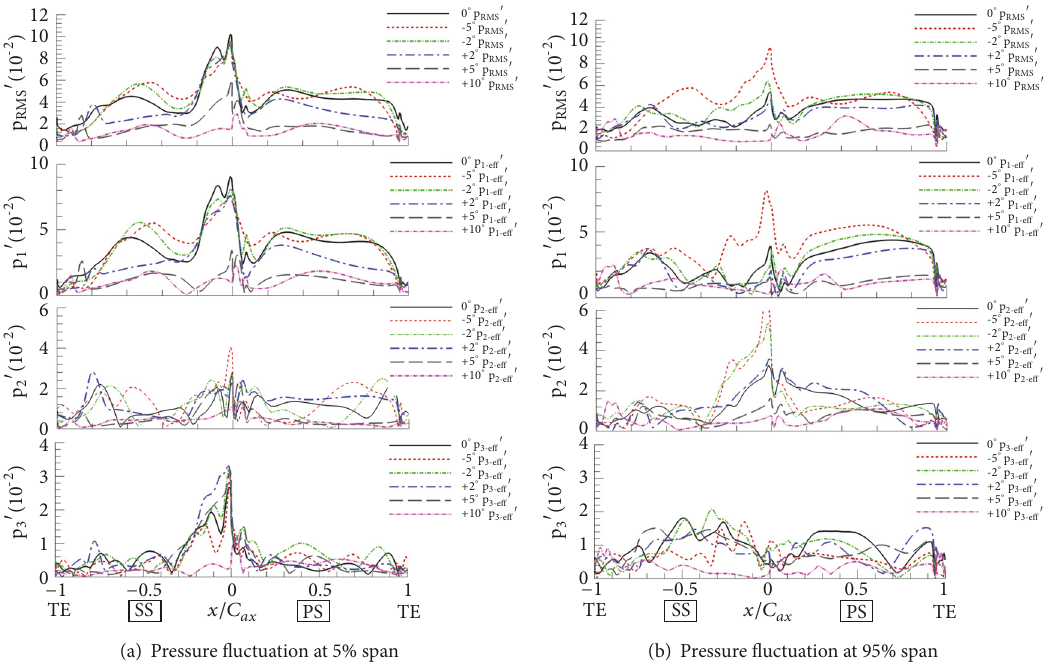
Figure 13: Pressure fluctuation distribution along the rotor blade surface at endwall regions.